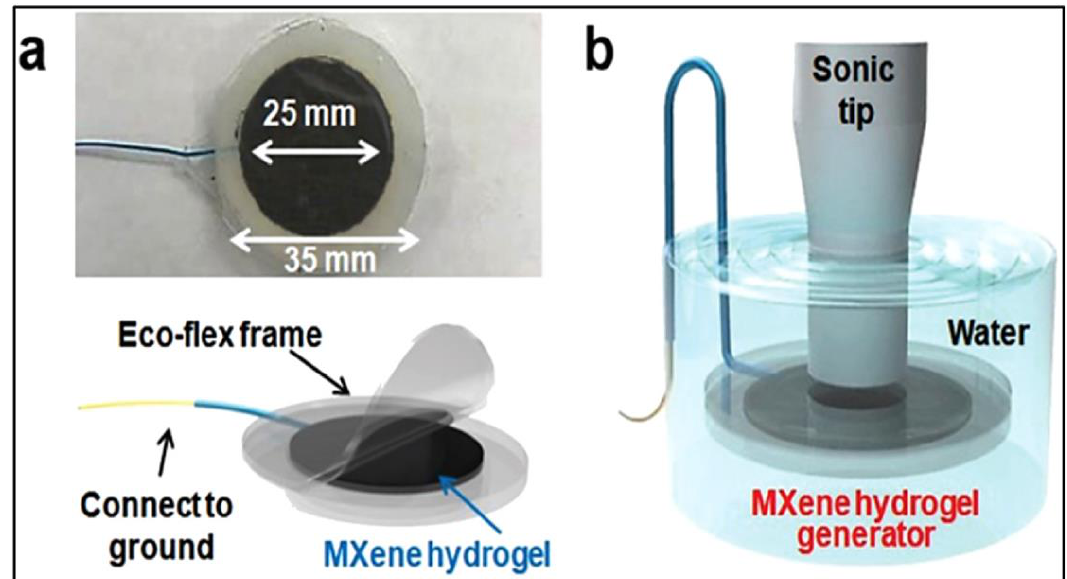
Figure 5. A simple MXene PVA-hydrogel Generator Setup Sketch ( a ) a thin hydrogel fixed between two ecoflex covers ( b ) the sonic tip generating output voltage. Reprinted with permission from [76], copyright 2020, American Chemical Society.